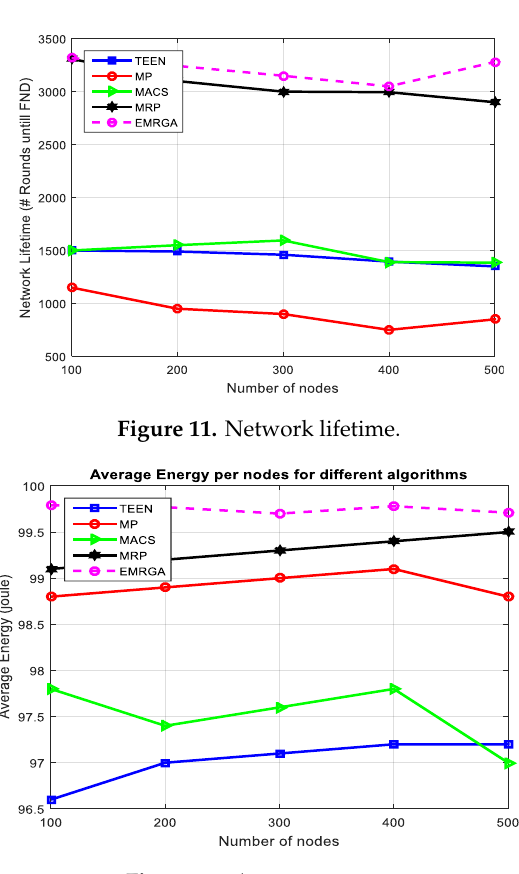
Figure 11. Network lifetime. Figure 12. Average energy.